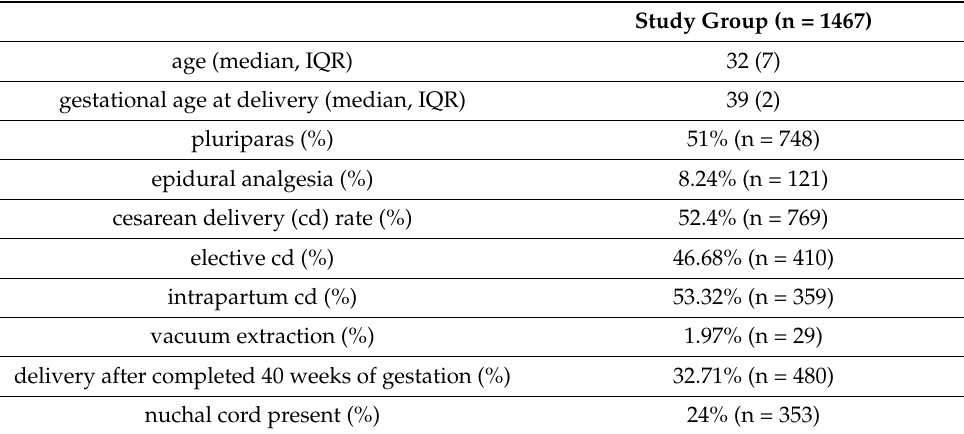
Table 1. Demographic characteristics of the